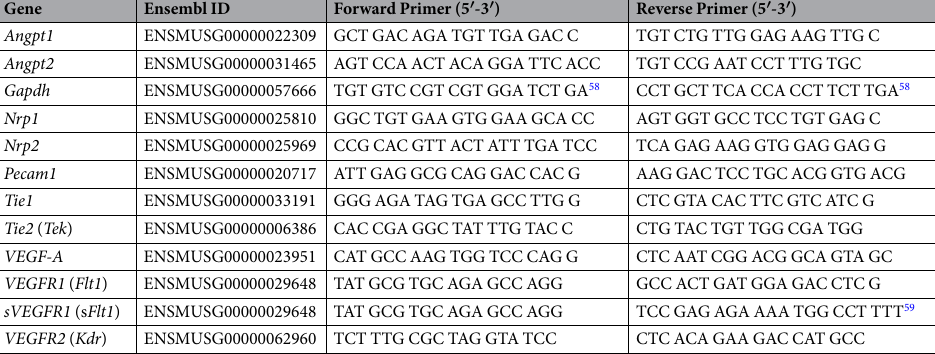
Table 1. Primers used for qPCR analysis. Angpt1 / 2 , angiopoietin 1/2; Gapdh , glyceraldehyde 3-phosphate dehydrogenase; Nrp1 / 2 , neuropilin 1/2; Pecam1 , platelet endothelial cell adhesion molecule 1; Tie1 / 2 , tyrosine kinase with immunoglobulin-like and EGF-like domains 1/2; VEGF-A , vascular endothelial growth factor A; VEGFR1 / 2 , vascular endothelial growth factor receptor 1/2; sVEGFR1 , soluble VEGFR1